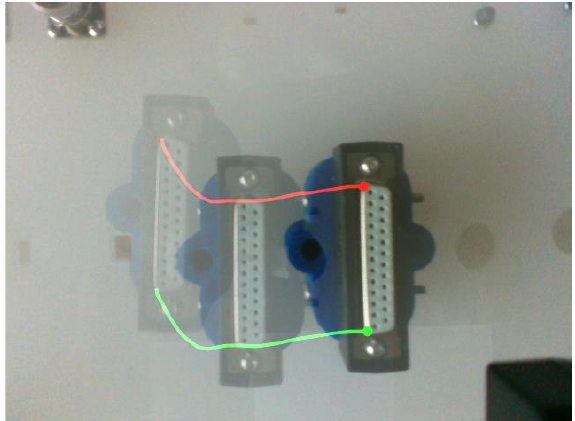
Figure 23. Visual servo process based on P2HNet.